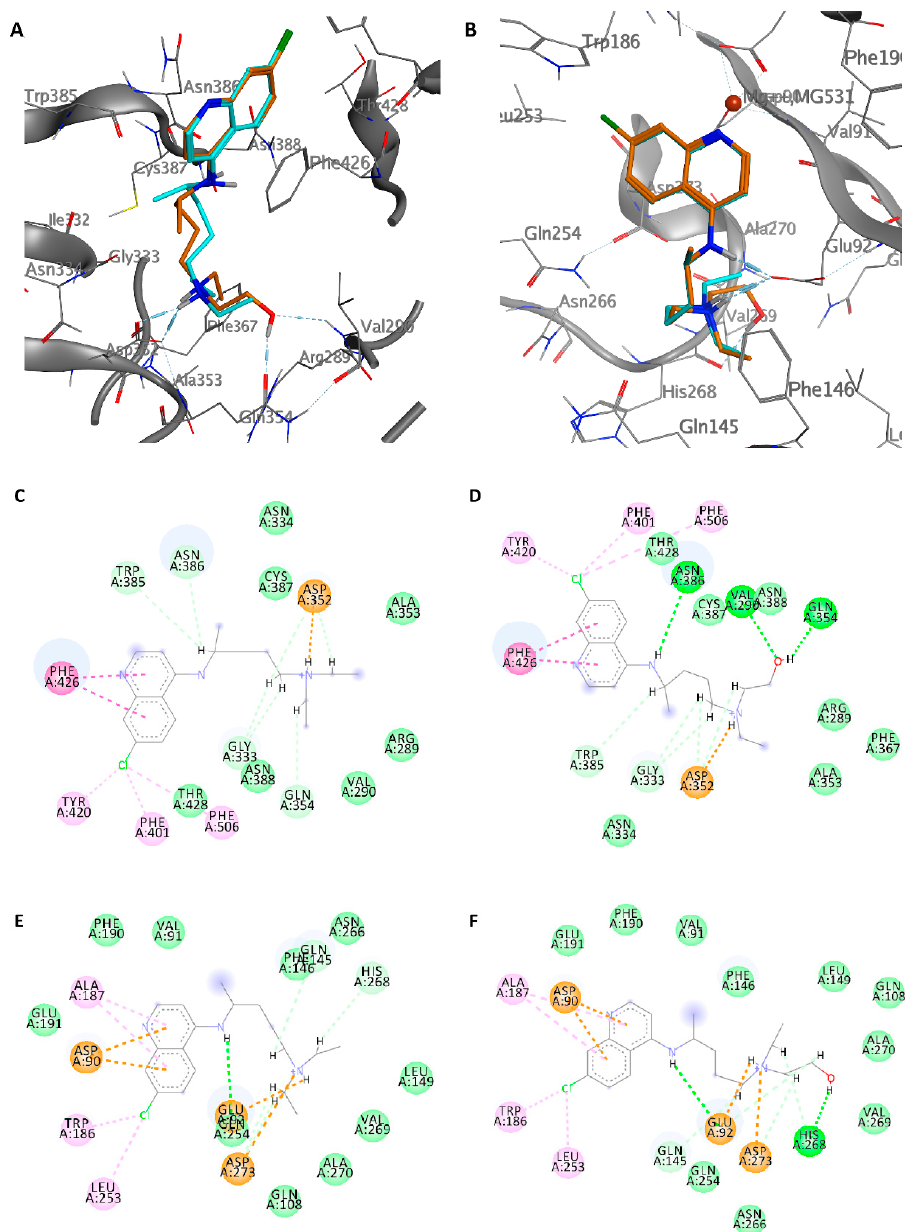
Figure 3. Interaction profile of the best-docked poses for CQ (blue) and HCQ (orange) in the N7-MTase ( A ) and ExoN ( B ) domain. Two-dimensional (2D) interaction diagram of CQ ( C ) and HCQ ( D ) in N7-MTase domain, and CQ ( E ) and HCQ ( F ) in ExoN domain.